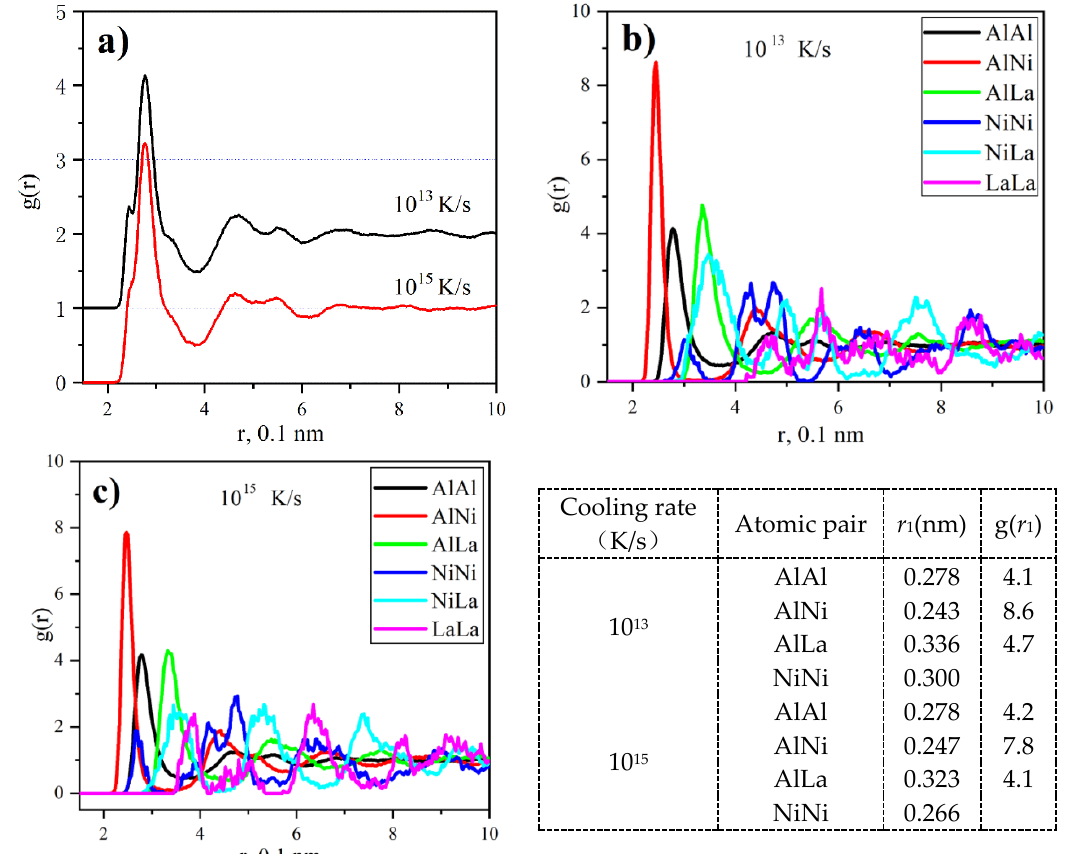
Figure 3. AIMD simulation of the Al 86 Ni 9 La 5 alloy cooled down from 1500 K to 300 K at the rate of 10 15 K/s and 10 13 K/s: ( a ) total pair distribution function g ( r ); ( b ) partial g ( r ) with the cooling rate of 10 15 K/s; ( c ) partial g ( r ) with the cooling rate of 10 13 K/s, the inset contains the parameters of the atomic pairs in ( b , c ).